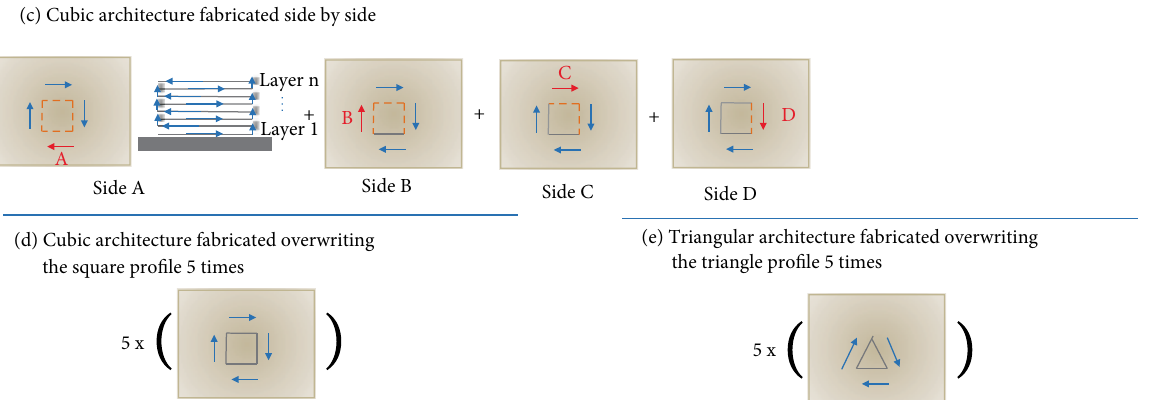
Figure 2: Schematic outline of three dimensional architectures: (a) a single wall free standing along the overlay, the blue arrows indicate the direction of printing, (b) a single wall was constructed crossing a matrix of single fibers, creating a sort of square profile where only one side was obtained by superimposition, (c) a cubic architecture was constructed side by side, starting from the ) all the adjacent sides were completed in a clockwise direction, and (d, e) cubic and triangular architecture fabrication of the first wall (side 𝐴 were obtained by overlay of the complete profile, starting from the first track, the same profile was overwritten. The blue arrows indicated the direction of printing.